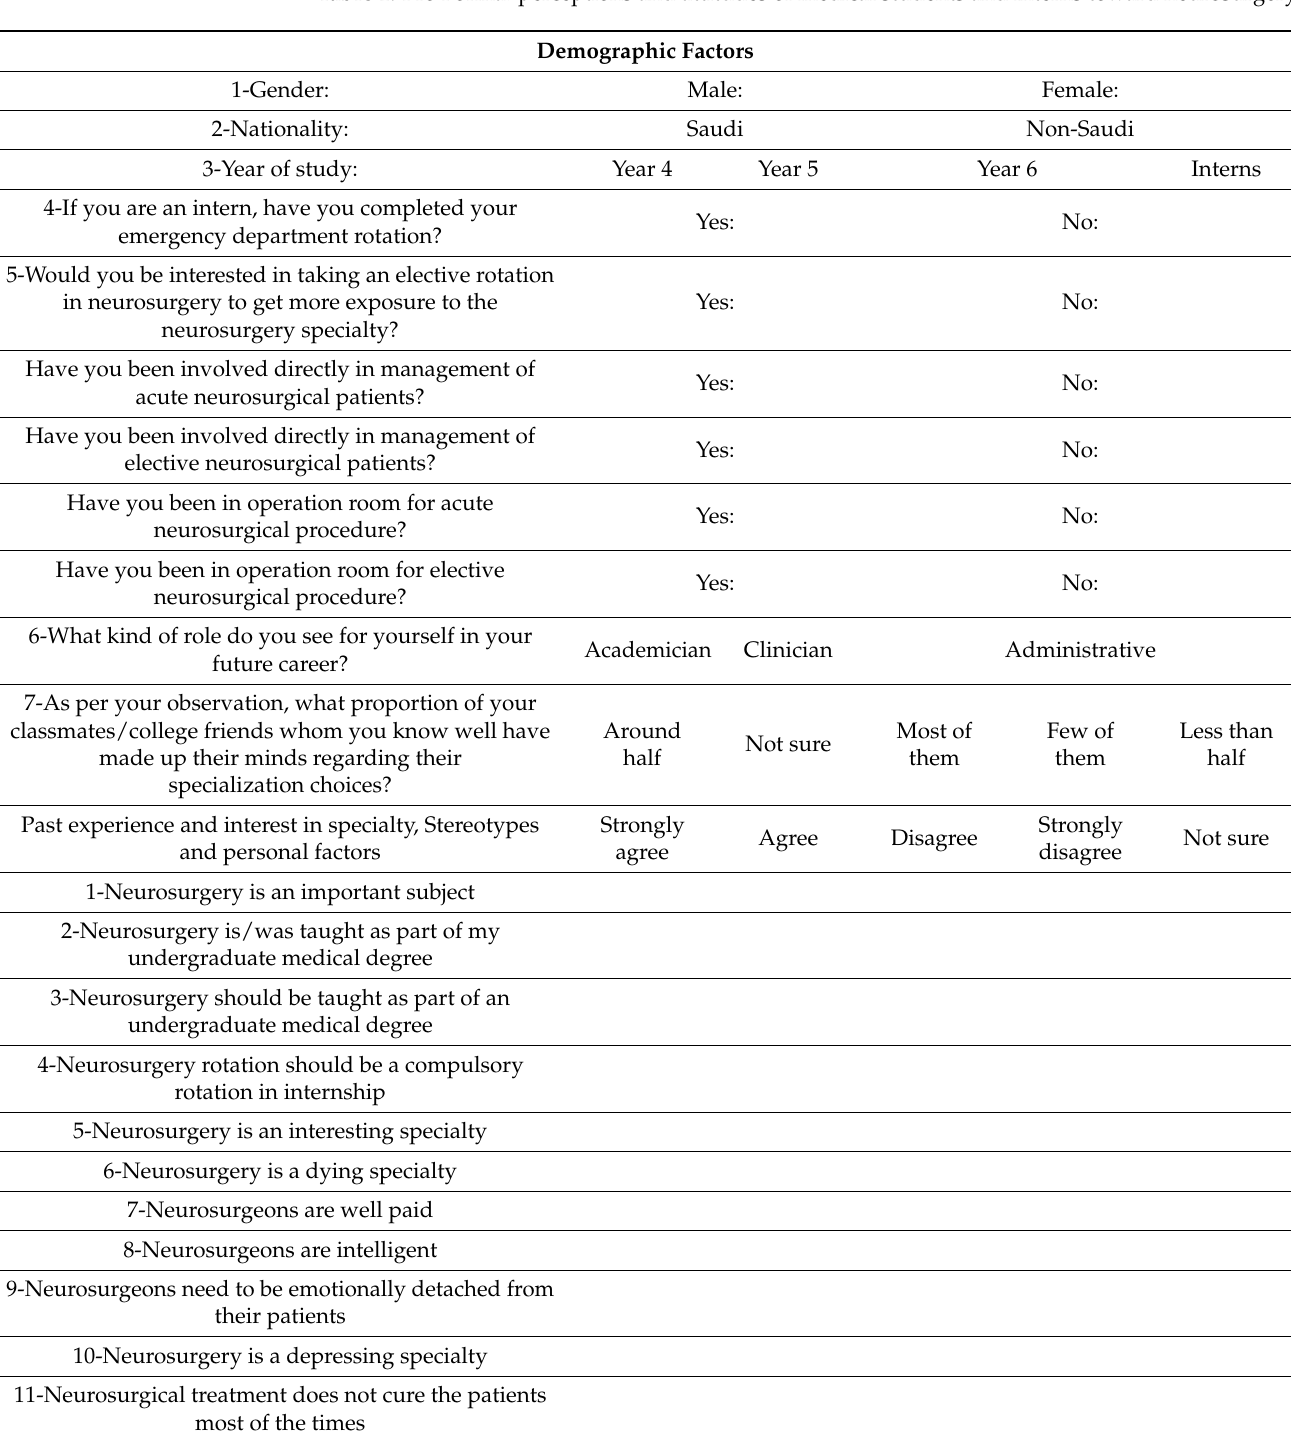
Table 1. Pro Forma: perceptions and attitudes of medical students and interns toward